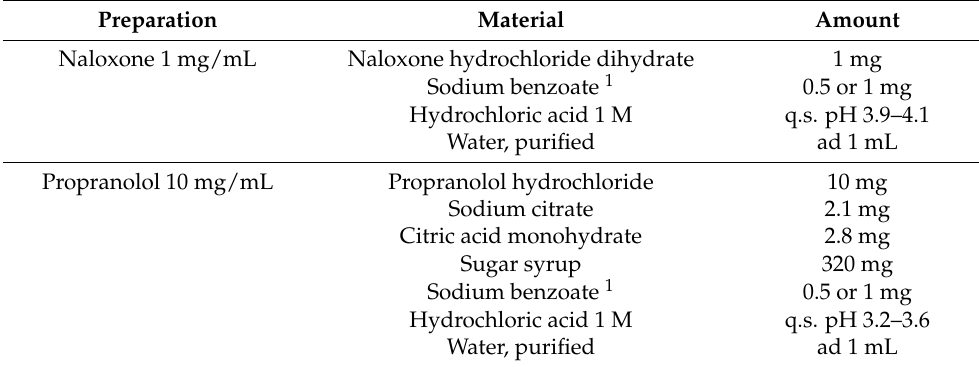
Table 7. Selected compositions of the two oral liquids after evaluation using multivariate data analysis.